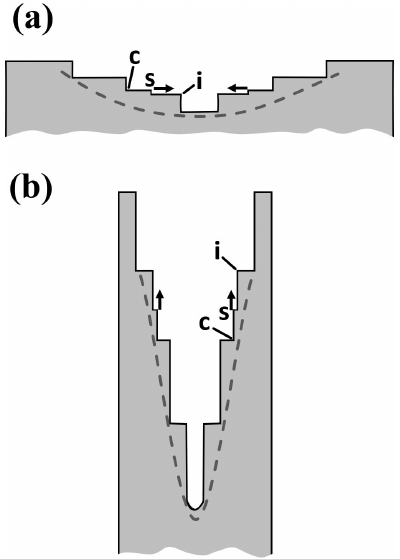
Figure B2. Terracing and banding in hollows. Sketches are cross sections of the top half of the crystal, the dashed lines represent- ing previous, smooth profiles. (a) A hollow on a squat crystal with terraces (may be either basal or prism face). On a sufficiently re- cessed terrace, the surface supersaturation increases towards the center from c to i, and thus single step s speeds up as it traverses the face, flattening the terrace. (b) A hollow on a long column or sheath with bands. Large macrosteps (e.g., with inside corner c) may pro- duce the observed banding. A single step s starting between c and edge i would speed up upon approaching i, flattening the band re-